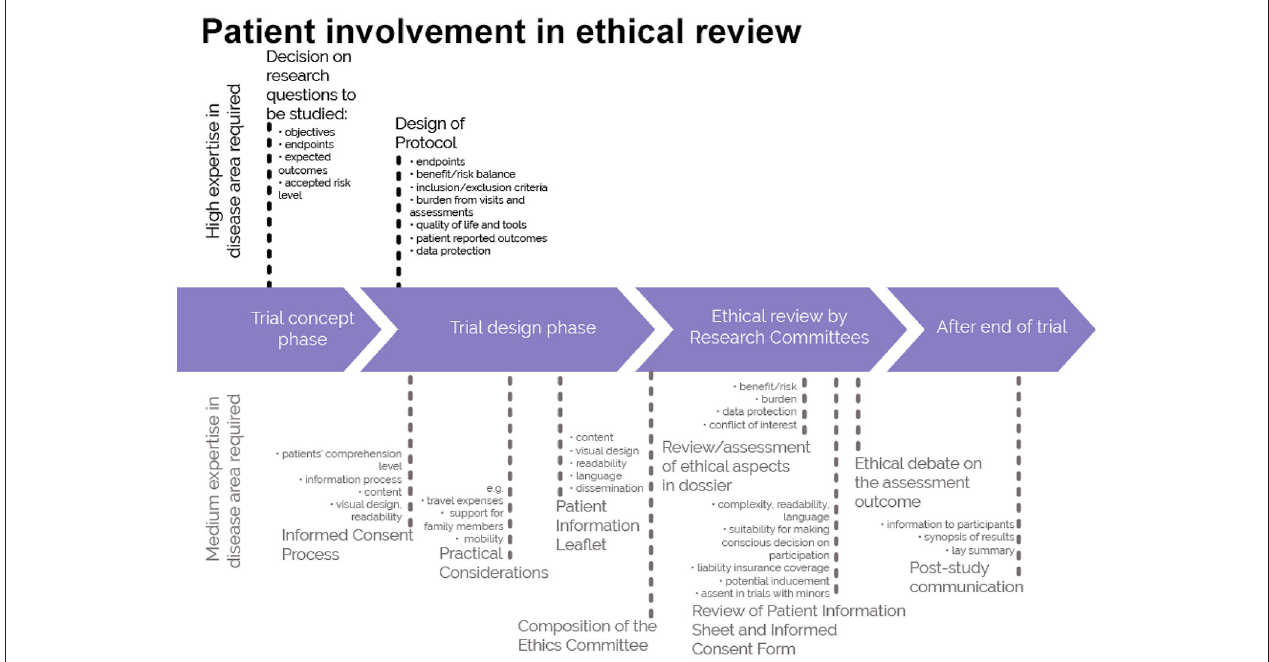
FIGURE 2 | A roadmap where patient involvement may occur in ethical review of clinical trials. Patients can meaningfully contribute across the clinical trial process. This diagram distinguishes between areas in the clinical trial process that require a high level or a medium level of expertise in the respective indication. ©